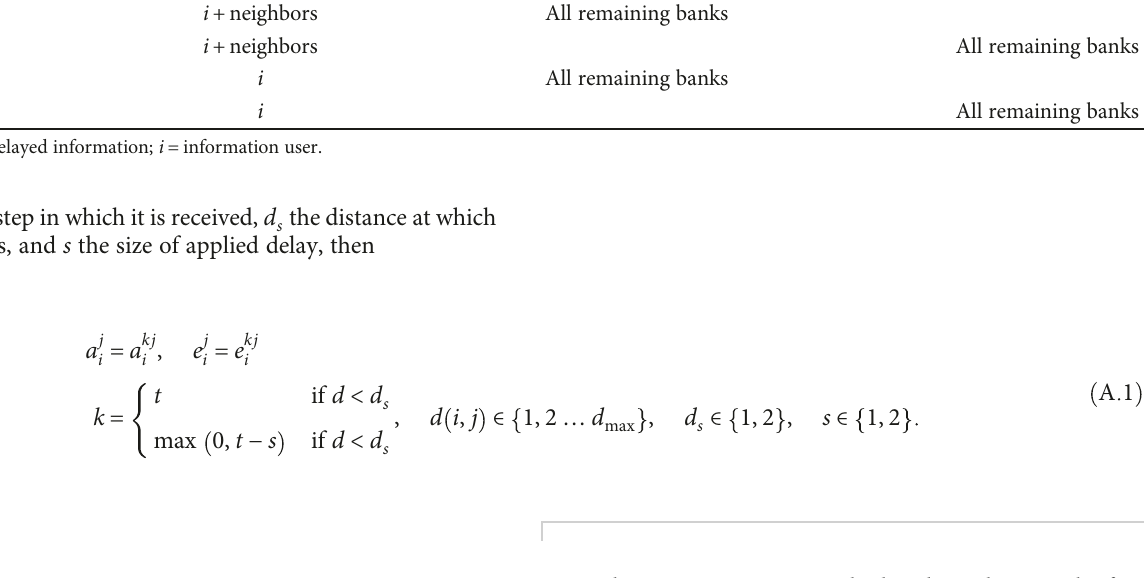
Table 1: The size of delay in time steps assigned to banks at di ff erent distance in di ff erent scenarios.